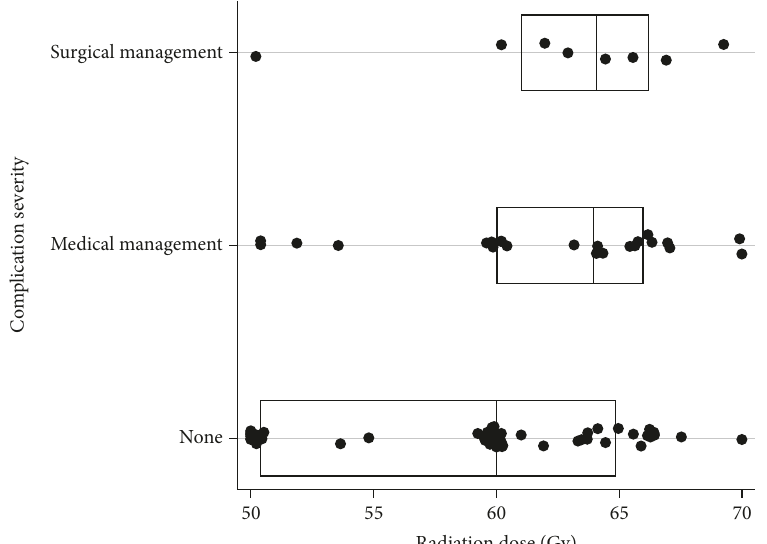
Figure 3: Complication severity by radiation dose. The box plot shows the median radiation dose received for patients based upon their complication severity (no complication, medical management required, and surgical management required). Eighty-seven of 102 patients had radiation dose data. Each dot represents a single patient’s radiation dose. The vertical line within each box represents the median dose for that severity group, and the left and right ends of the box represent the interquartile range (IQR). The median radiation dose received for all patients was 60 Gy (55–66). The median doses for the none, medical management, and surgical management complication groups were 60Gy (50.4–64.9), 64 Gy (60–66), and 64.1 (61–66.3), respectively. No differences in dose were found between the three groups Spearman’s rank correlation between radiation dose and complication severity was ρ positive